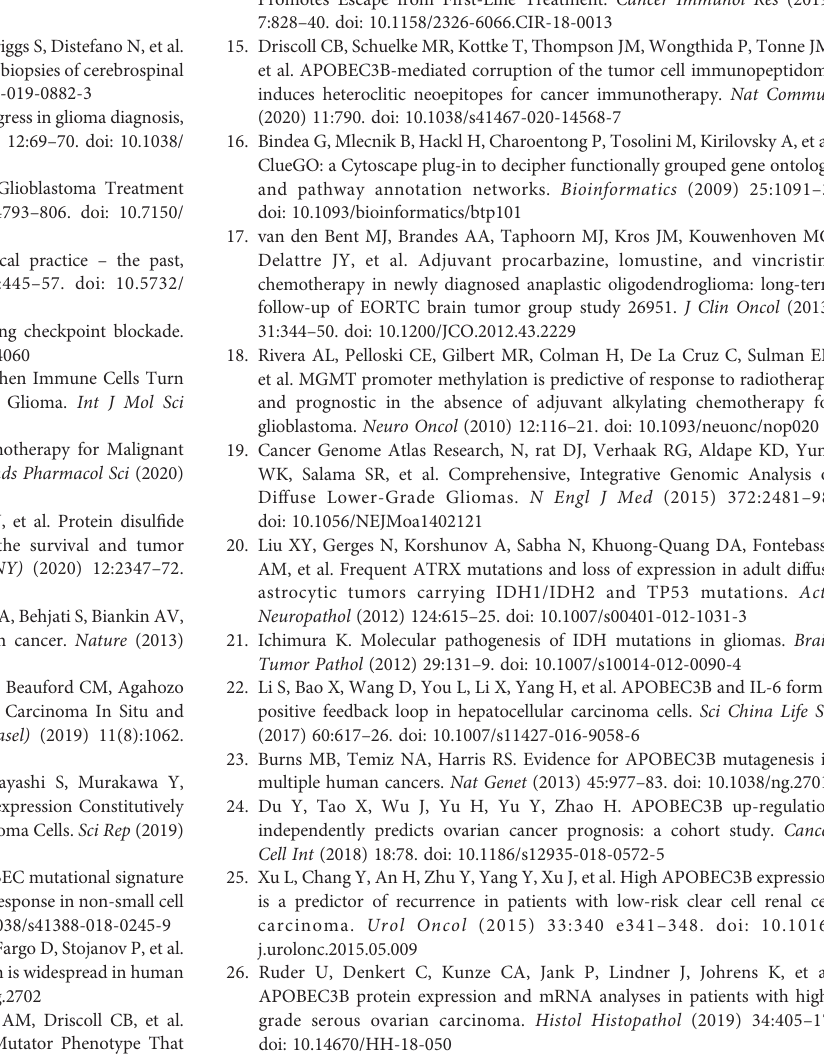
Supplementary Figure 3 | APOBEC3B-related biological functions in gliomas. GO analysis based on APOBEC3B levels in (A) TCGA and (C) CGGA datasets in pan-glioma analysis. KEGG pathway analysis based on APOBEC3B expression levels in (B) TCGA and (D) CGGA datasets in pan-glioma analysis. Supplementary Figure 4 | Heatmaps illuminating APOBEC3B related in fl ammatory activities in LGG and pan-glioma. Analysis between APOBEC3B and in fl ammatory metagenes in LGG from (A) TCGA and (B) CGGA datasets and pan- glioma analysis from (C) TCGA and (D) CGGA. Supplementary Figure 5 | Correlation between APOBEC3B expression and ESTIMATE algorithm scores in gliomas. APOBEC3B expression was positively correlated with immune score, stromal score and ESTIMATE score in (A) pan- glioma analysis and (B) LGG patients. The relationship between APOBEC3B and stromal cell populations based on (C) TCGA and (D) CGGA in LGG patients. Supplementary Figure 6 | Heatmaps illustrating the relationship between APOBEC3B and immune cell populations based on (A) TCGA and (B) CGGA in pan-glioma analysis. The relationship between APOBEC3B and stromal cell populations based on (C) TCGA and (D) CGGA in pan-glioma